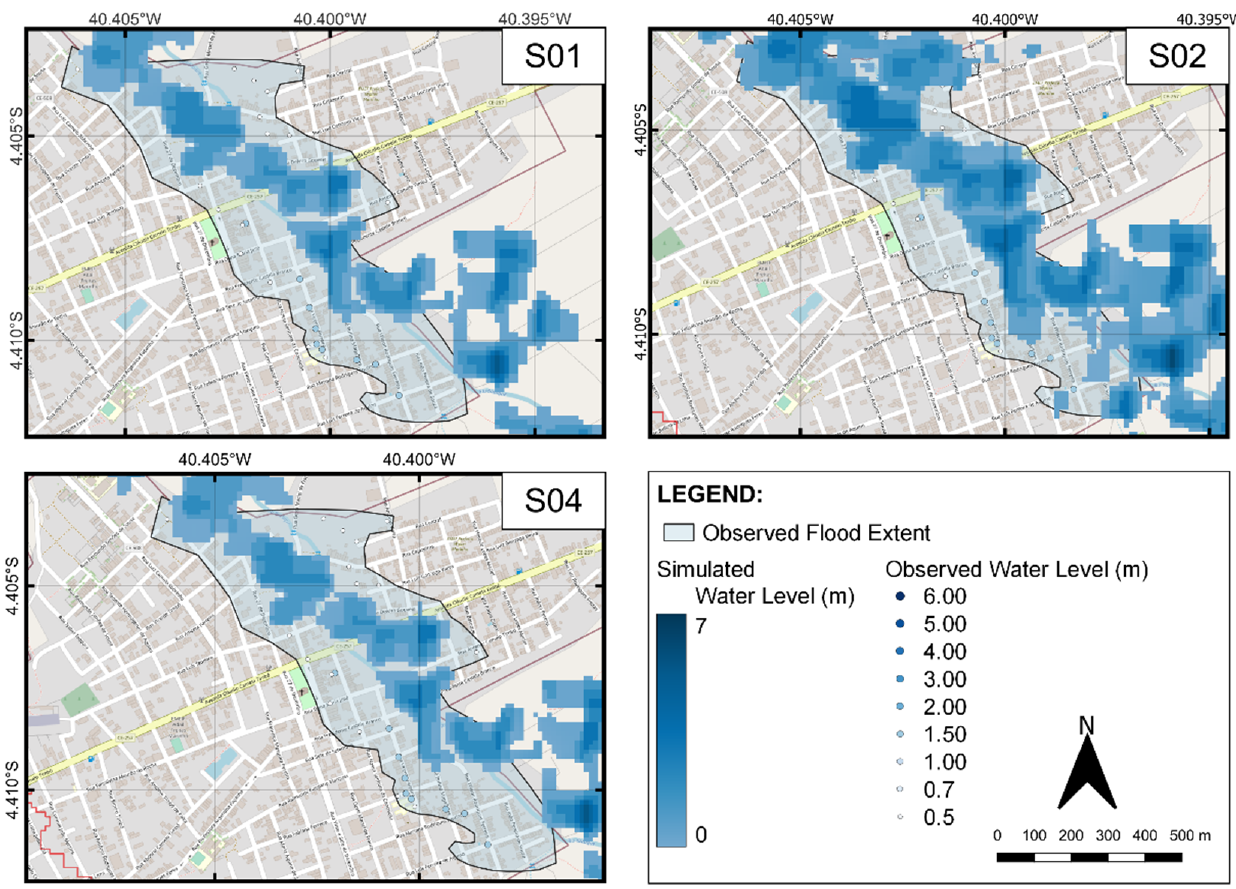
Figure 13. Simulated floodplains versus the observed floodplains for scenarios S01, S02, and S04. The result of the flooded patch generated by the isolated action of 93 mm rain